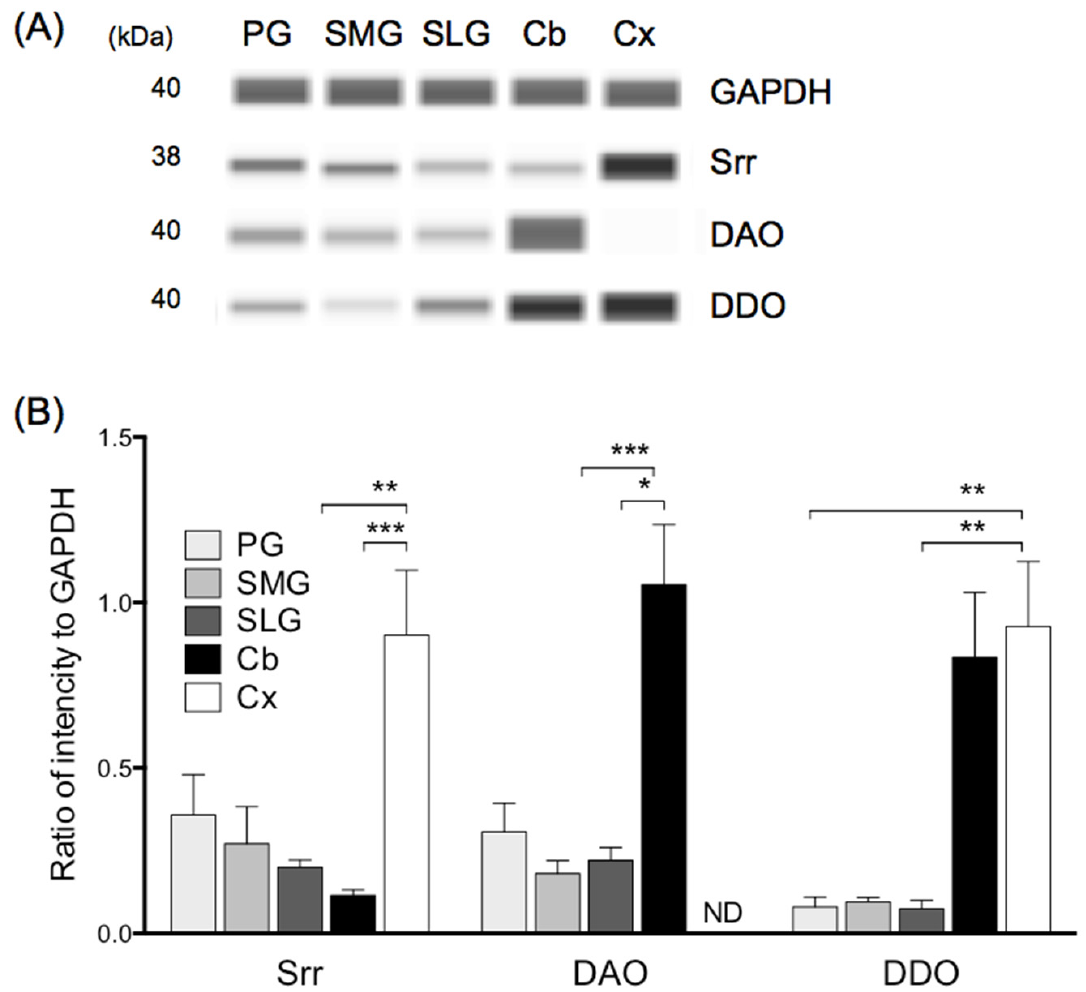
Figure 2. Protein levels of serine racemase (Srr), D -amino acid oxidase (DAO) and D -aspartate oxidase (DDO) in three salivary glands, cerebellum, and cerebral cortex in rat. ( A ) Typical Simple Western image of Srr, DAO, DDO and glyceraldehyde-3-phosphate dehydrogenase (GAPDH). ( B ) Values were normalized to housekeeping gene GAPDH. Values represent mean ± SD in 5 rats. Signifi- cantly different from cerebral cortex (Srr, DDO) or cerebellum (DAO) according to Dunn’s post hoc test following Kruskal–Wallis test; * p < 0.05, ** p < 0.01, and *** p < 0.001. PG, parotid gland; SMG,